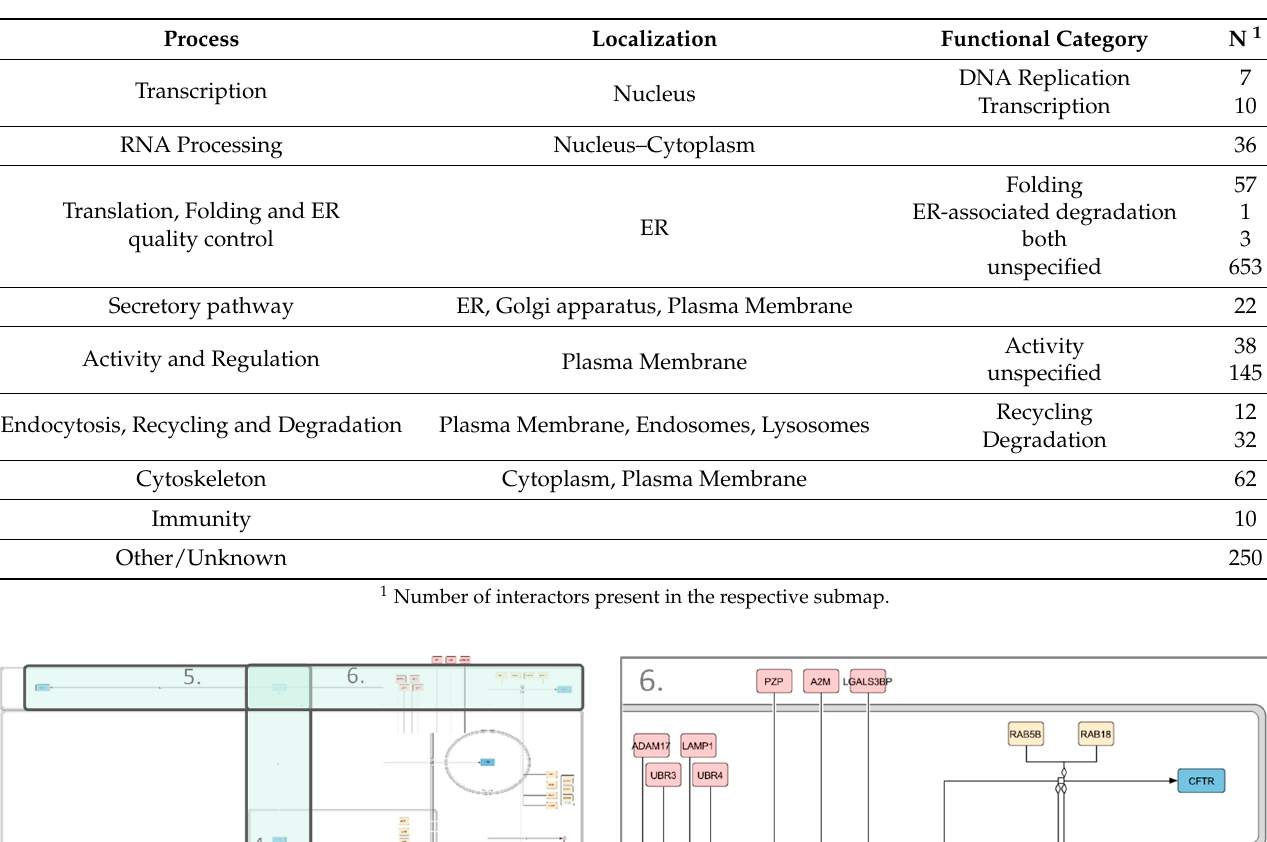
Table 2. Description of the five submaps of the CFTR high-throughput model.